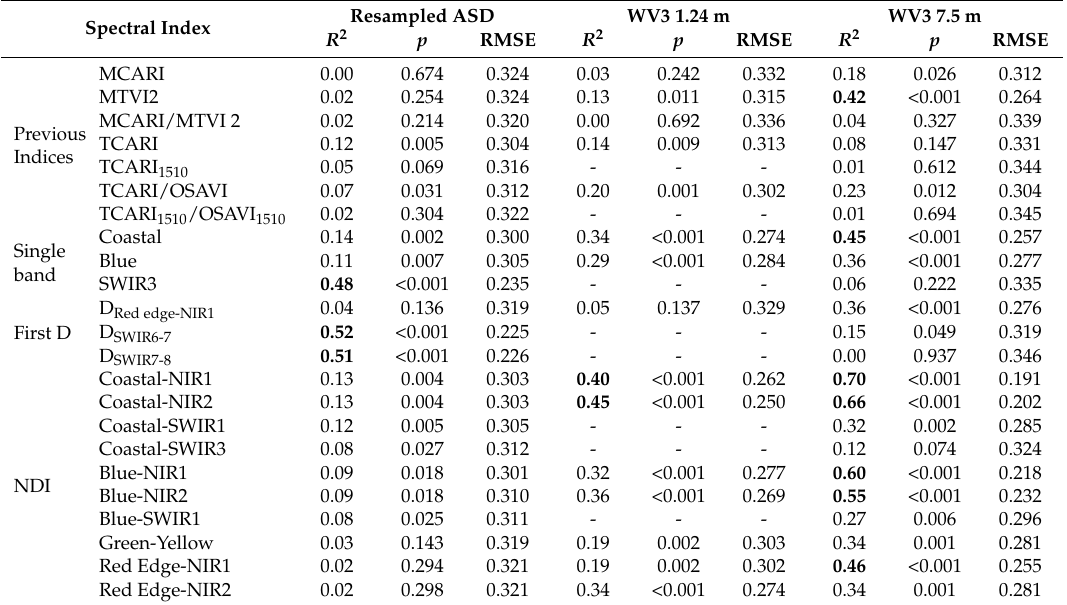
Table 4. Coefficient of determination ( R 2 ), p-value and RMSE (% dry matter) for various spectral indices used as regression estimators of foliar digestible nitrogen concentration (DigN; % dry matter) in eucalypts. Spectral indices were calculated from three datasets including resampled ASD spectra,